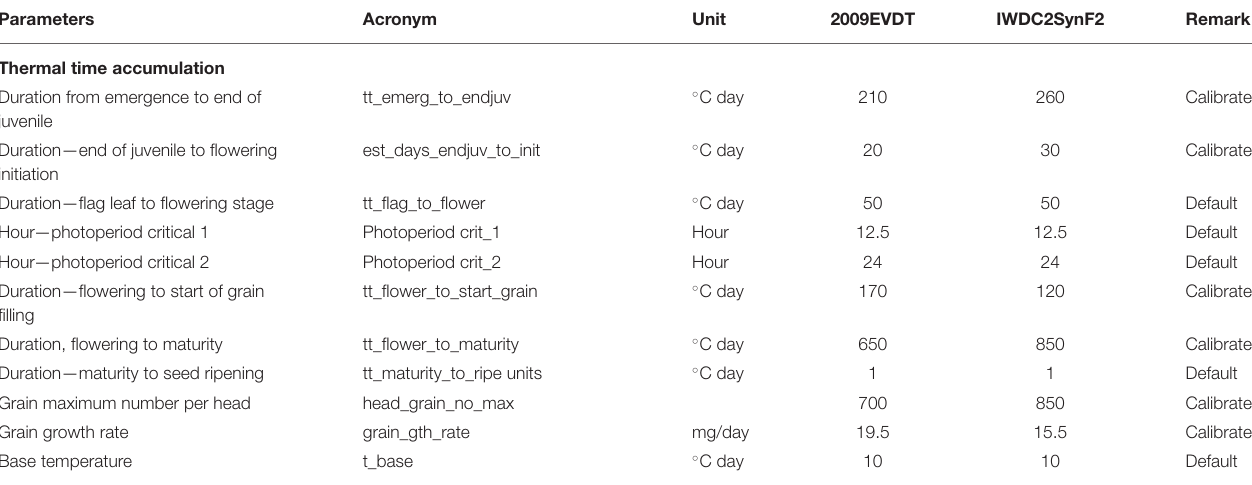
TABLE 2 | Calibrated cultivar specific parameters for 2009EVDT and IWDC2SynF2 maize varieties. Parameters